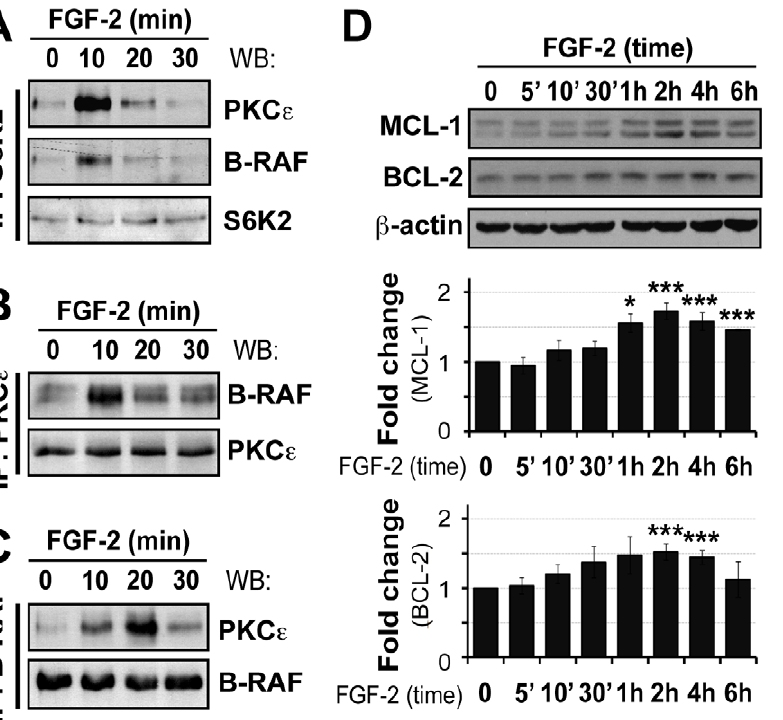
Figure 2. FGF-2 induced interactions between S6K2, PKC e and B-RAF, and upregulation of anti-apoptotic proteins in U2OS cells. Cells were serum-starved as before and after stimulation with FGF-2 (10 ng/ml), proteins extracted using the co-immunoprecipitation lysis buffer. Cell lysates were subjected to immunoprecipitation with ( A. ) S6K2, ( B. ) PKC e or ( C. ) B-RAF antibodies and proteins detected by western blotting as indicated. D. Western blot analysis was performed using total cell lysates and antibodies against MCL1 and BCL-2. b -actin was used as a loading control. Representative western blots and mean 6 SEM from three independent experiments are shown in graphs. ‘ – min.